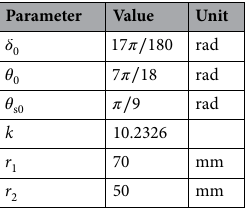
Figure 6a is the cam ring slot of the prototype calculated with Eqs. (12) and (14). This cam slot curve is a closed curve composed of two concentric arcs (i.e., arc CB and arc DA) and two transition curves(i.e., curve CD and curve BA). The markers “*” are accurate positions of the aforementioned Point A, Point B, Point C, and Point D in Fig. 2, and “ ● ” is the contact point between the sliding vane and the cam ring slot, which is named Point P and moves along the curve. Figure 6b presents the variation of the pressure angle when the sliding vane moves along the cam ring slot, which indicates the continuity of the pressure angle. Figure 7 shows the rate of change of the length OP and its derivative when the contact point P moves along the cam slot, where r is the length of OP. The changing rate of the length OP is not a smooth curve, and the motions of the sliding vanes produce acceleration shocks acting on the shell. These shocks are stronger along with the higher rotational speed of the rotor shaft. Modifying the curve of the cam ring slot could minimize the shock. Figure 8 describes the rate of change of the length OP and its derivative when 𝛿 0 is 𝜋 ∕ 9 . Compared with Fig. 7, the amplitude of the rate of change of the length OP increases about 0.004 m/rad, while the amplitude of its derivative decreases sharply to half of its previous value, which will relieve the acceleration shock. Calculation of fluid resistance coefficient. The local resistance coefficient of the fluid is usually acquired with experiment or computational fluid dynamics (CFD) simulation. In this paper, a CFD software named FloEFD is adopted due to the lack of experimental conditions. FloEFD is a commercial software, which has the function of auto meshing and seamless integration with CAD software, e.g., Creo, CATIA, SolidWorks. In the simulation, water is the selected fluid, and Fig. 9 shows the boundary conditions and results of the simula- tion when the angle of the valve core is 26.08°. So, the local resistance coefficient of the fluid at this valve angle is acquired with Eq. (5). In the prototype, the actual angle range of the valve core, 𝜃 V , is from zero, a full-open position, to 83.62°, a closed position. Because the simulation could not run when the valve core is in the closed position, the range in the simulation is from zero to a nearly closed-angle, 83.5°. Thus, a series of local fluid resistance coefficients are achieved according to Eq. (5) and the fluid pressures acquired from the simulation at each valve core posi- tion. The results in Table 2 validate the monotone increasing relationship between the local fluid resistance coefficients, f ( 𝜃 V ) , and 𝜃 V .